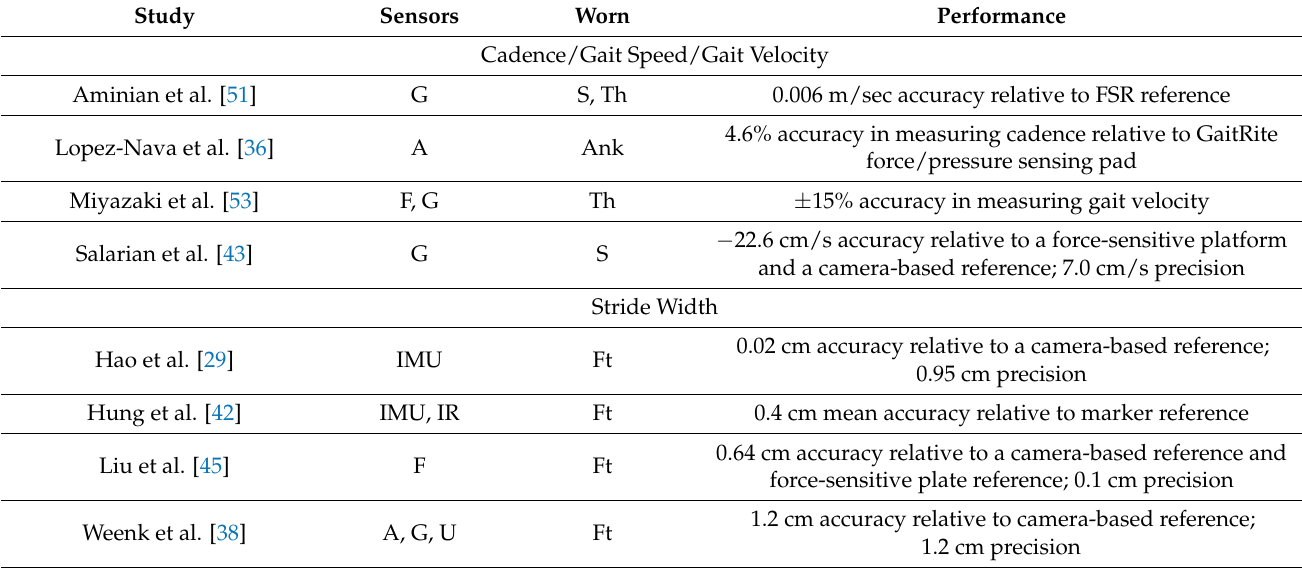
Table 3. Performance of Wearable Sensors in Measuring Stride Width or Cadence/Gait Speed.